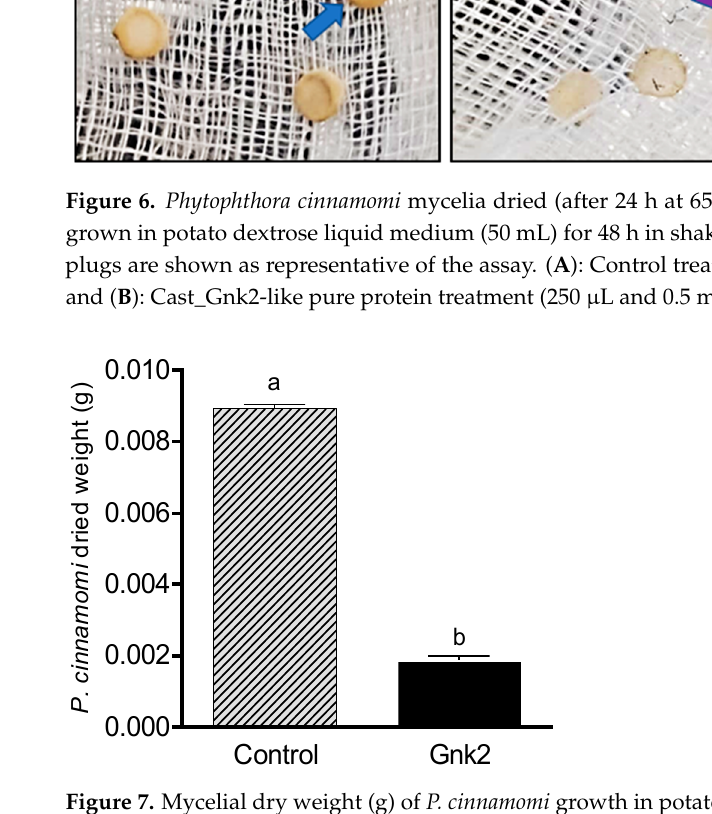
Figure 7. Mycelial dry weight (g) of P. cinnamomi growth in potato dextrose liquid medium (50 mL) under control treatment (only with buffer solution) and Cast_Gnk2-like pure protein treatment (250 µ L and 0.5 mg/mL) after 48 h in shaking (180 rpm) at 25 ◦ C. Results are shown as means ± SEM. Significant differences are shown as different letters ( t -test, p < 0.05).